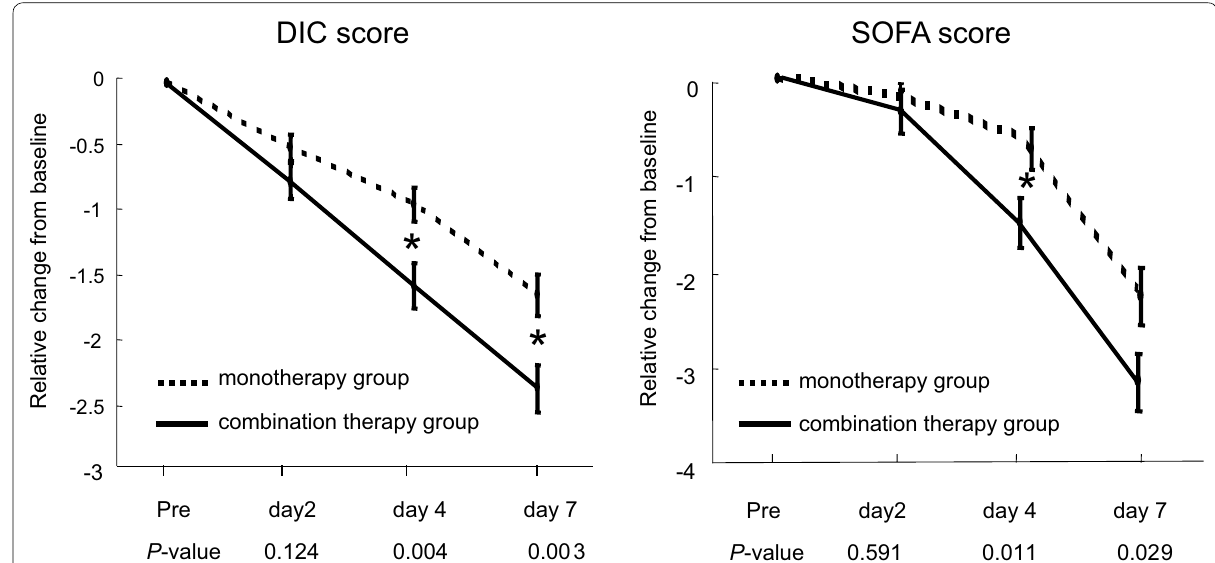
Fig. 3 Changes in JAAM-DIC score and SOFA score in the propensity score-matched combination therapy and monotherapy groups. The JAAM-DIC scores were significantly lower in the combination therapy group than in the monotherapy group on Day 4 and Day 7 ( P tively). The SOFA scores were significantly lower in the combination therapy group on Day 4 ( P